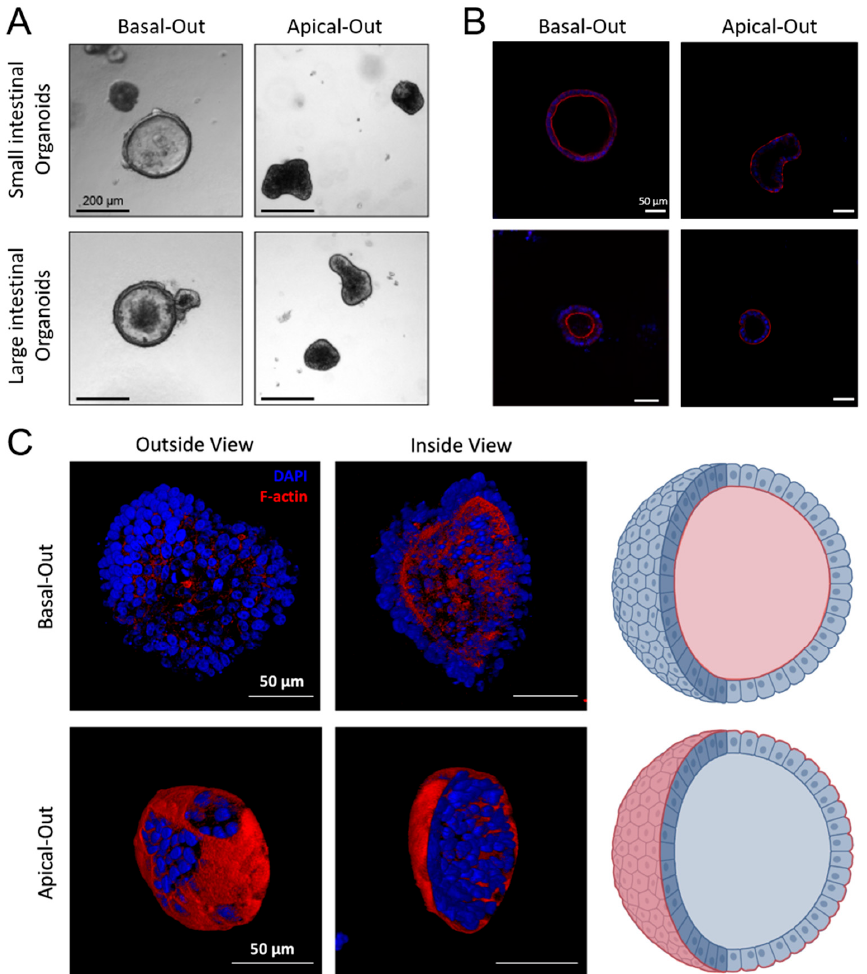
Figure 4. Characterisation of canine small and large intestinal apical out organoids. ( A ) Basal-out and apical-out organoids showed different morphologies as documented by brightfield microscopy. ( B ) Basal-out and apical-out organoids were stained with DAPI (blue) and Phalloidin (red) to visualise F-actin-rich microvilli on the apical cell surface of intestinal epithelial cells. ( C ) Three-dimensional rendering of basal-out and apical-out organoids, including a scheme depicting dense microvilli on the inside in basal-out organoids and on the outside in apical-out organoids.